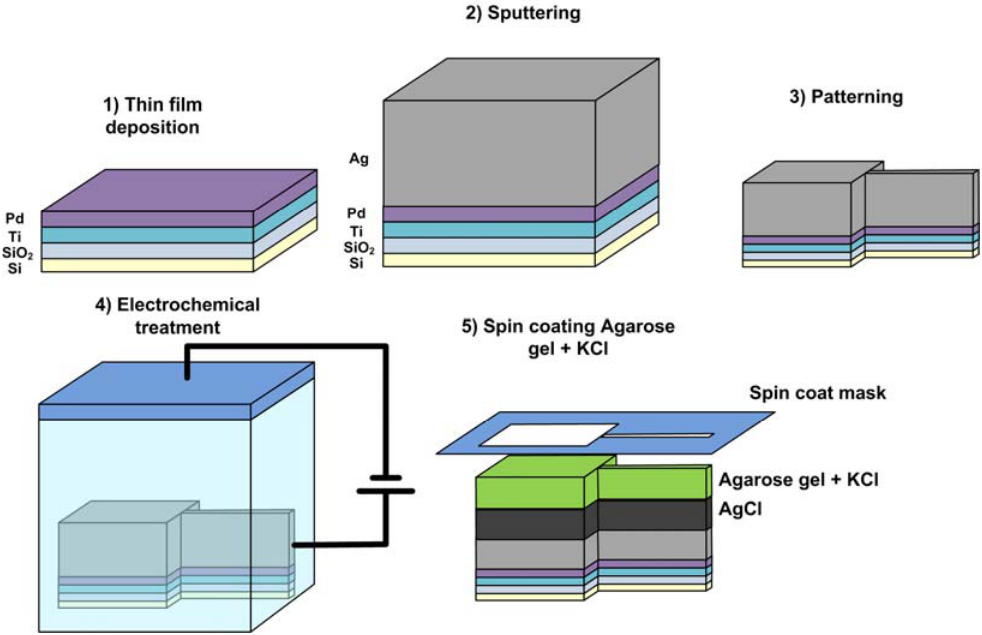
Figure 6. Steps in microfabricating a fully solid-state reference electrode [48].